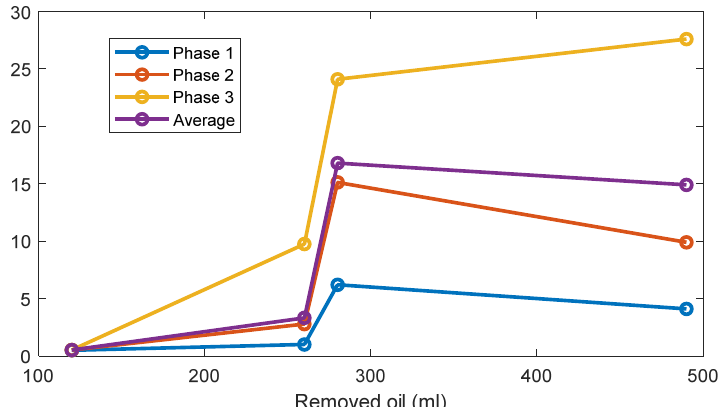
Figure A12. The FC of Feature 2 for 3 phases and 4 levels of oil removal compared to the standard oil level (Day 1 + Day2).